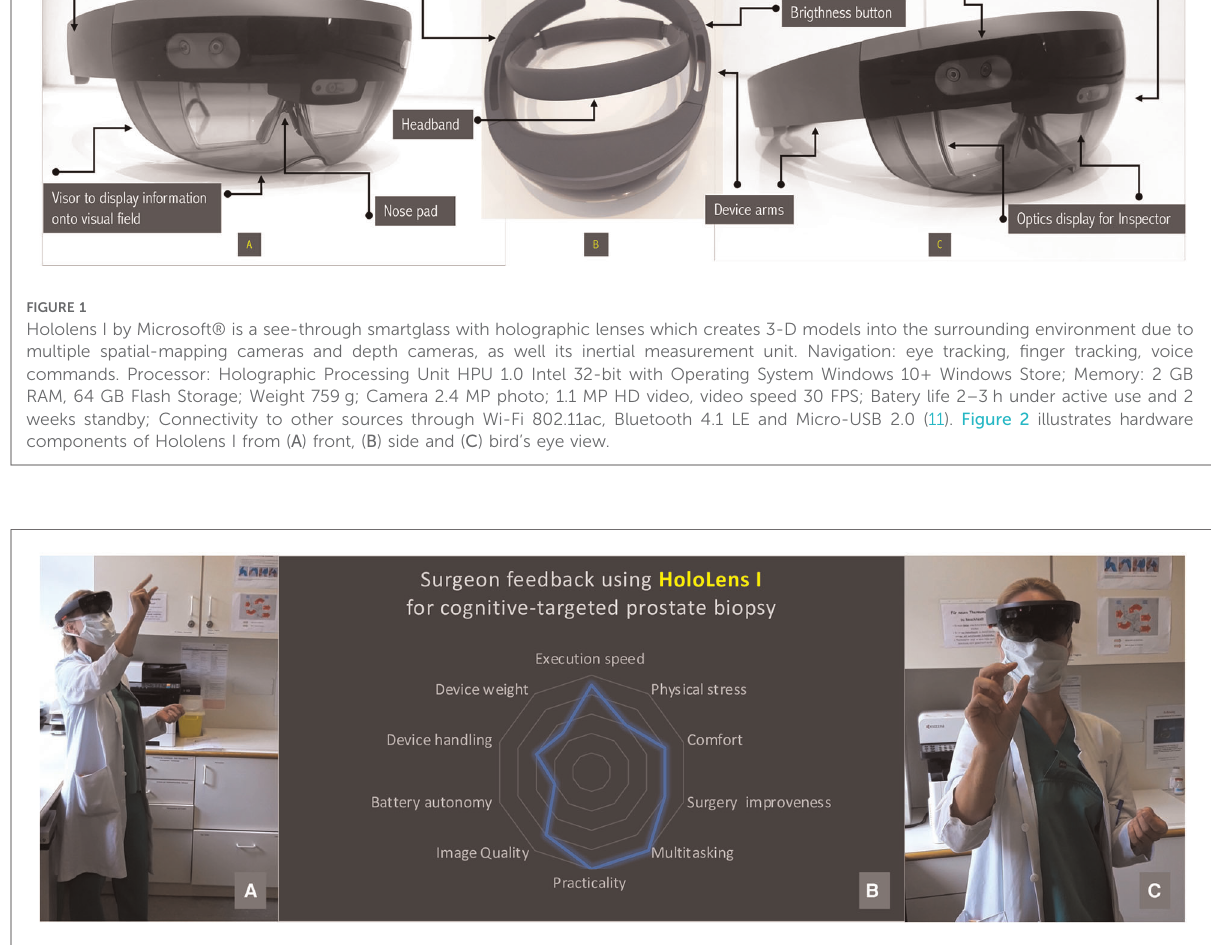
FIGURE 2 Illustration of surgeon wearing Hololens smartglass and navigation by fi nger tracking [picture ( A,C )]. Surgeons ’ feedback for using Hololens I for cognitive-targeted prostate biopsy including an assessment from bad to excellent for speci fi c domains [picture ( B